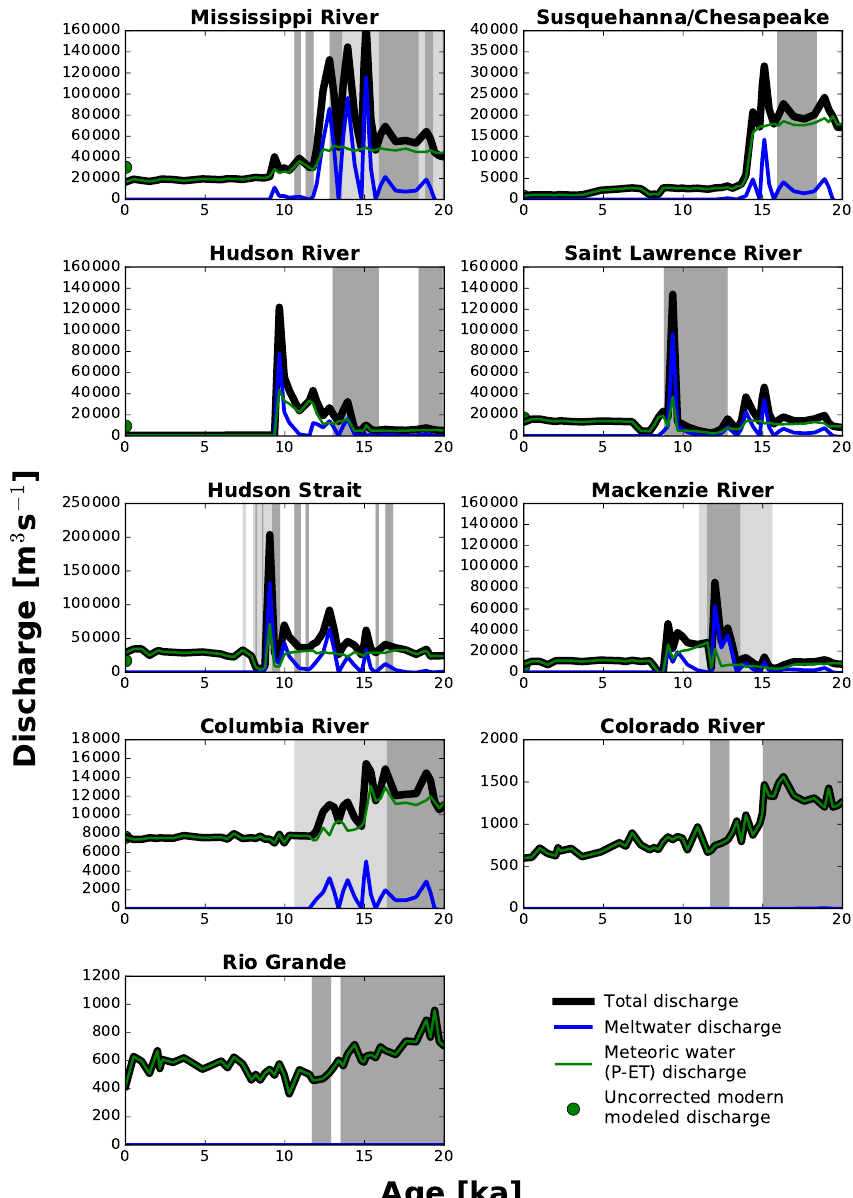
Figure 12. Computed discharge based on the ANU ice-sheet–solid-Earth model pair (Lambeck et al., 2002), compared to the geologic record of enhanced past discharge (gray shading: dark, direct record; light, inferred and/or less-enhanced discharge). Notes on the geologic record can be found in Fig.